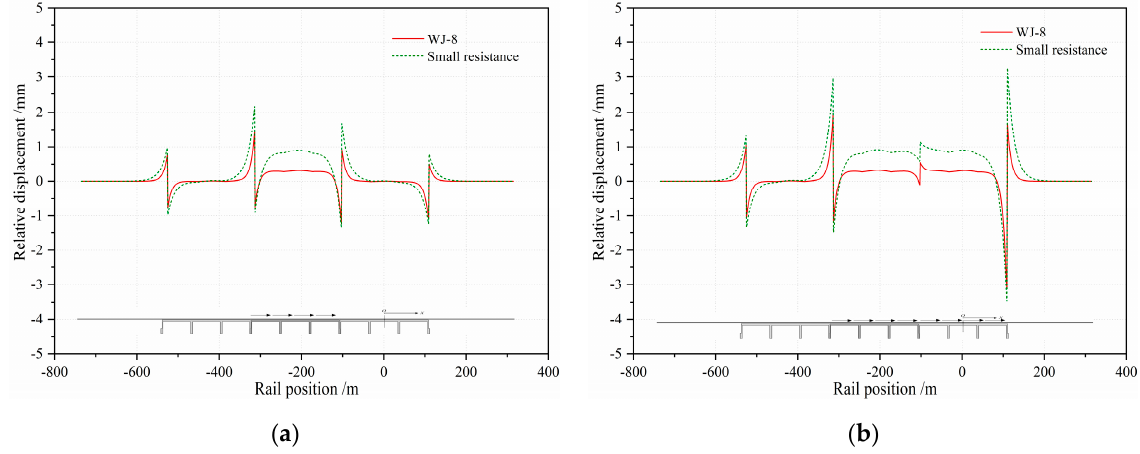
Figure 13. Relative displacement between rail and beam under different conditions: ( a ) condition I; ( b ) condition II.